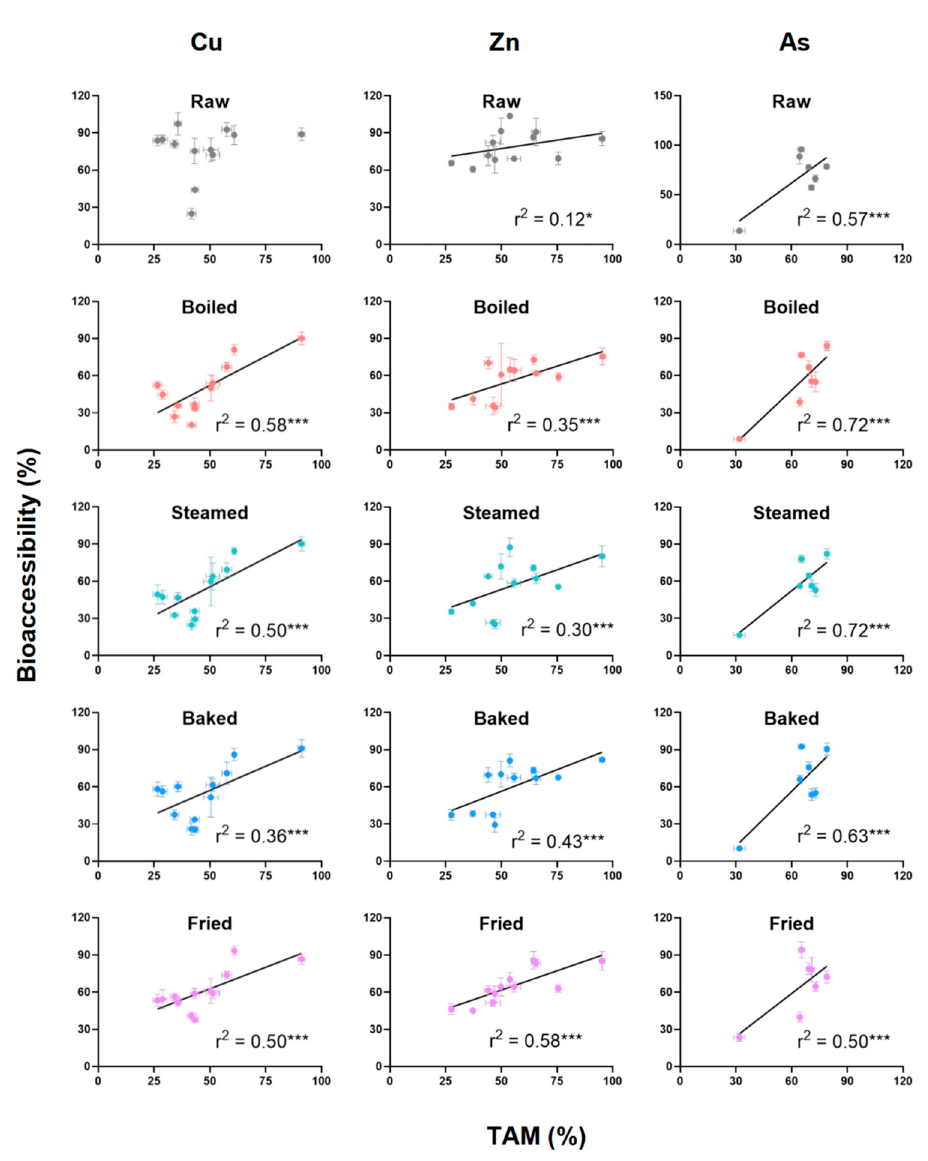
Figure 5. The correlation between trophically available metals (TAM) and the bioaccessibility of Cu, Zn, and As in food ingredients. TAM: organelles + HDP + HSP. The asterisk indicates there is a significant correlation ( * : p < 0.05; *** : p < 0.001).